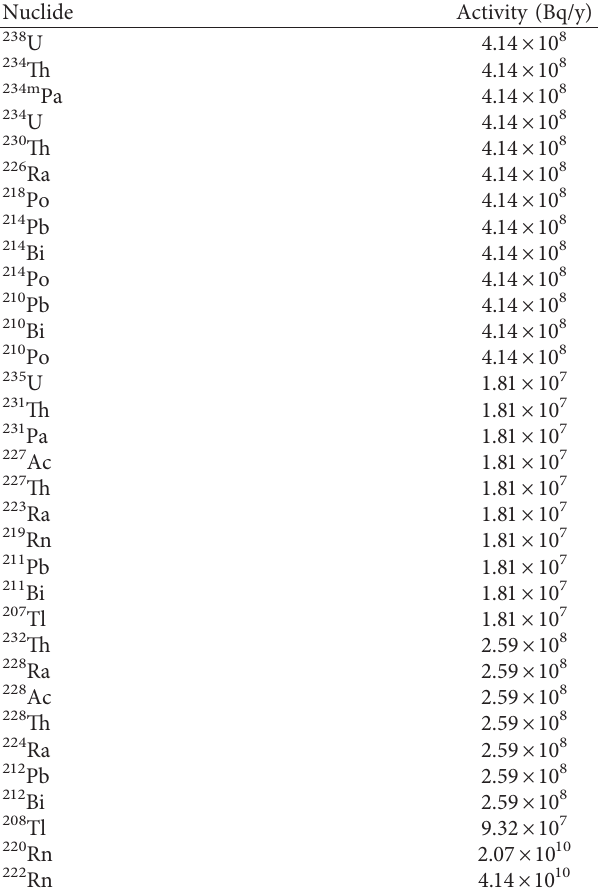
Table 3: Source term for CAP88-PC